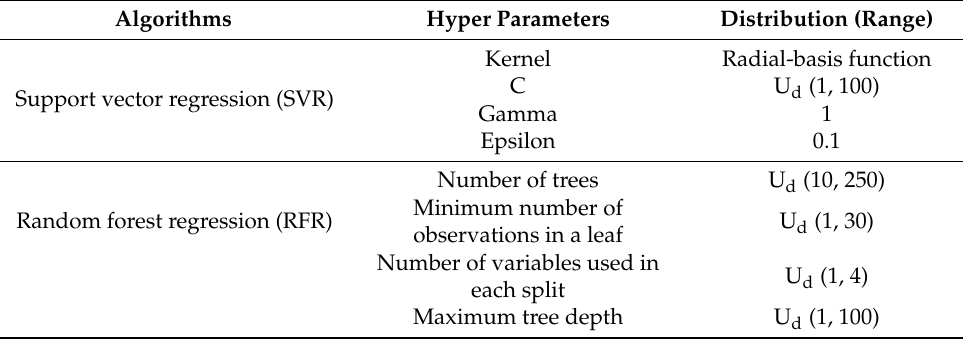
Table 3. Cont. Algorithms Hyper Parameters Distribution (Range) Kernel Radial-basis function C U d (1, 100) Support vector regression (SVR) Gamma 1 Epsilon 0.1 Number of trees U d (10, 250) Minimum number of Random forest regression (RFR) U d (1, 30) observations in a leaf Number of variables used in each